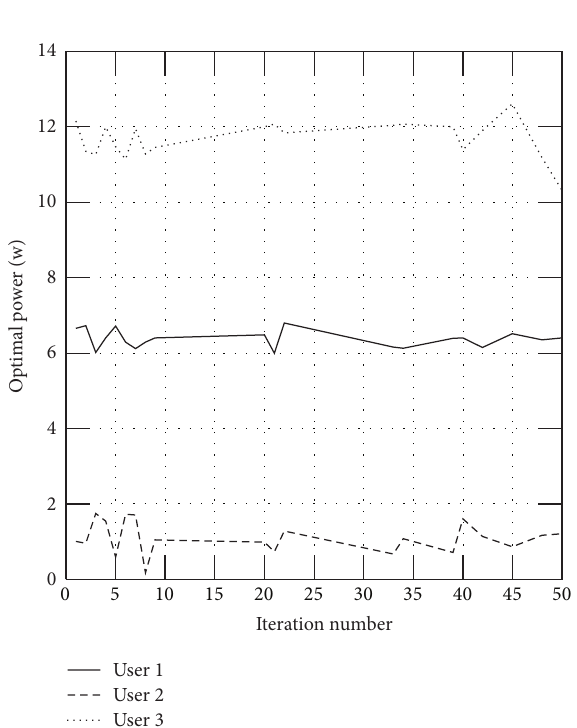
Figure 2: Optimal power without the parameter 𝜆